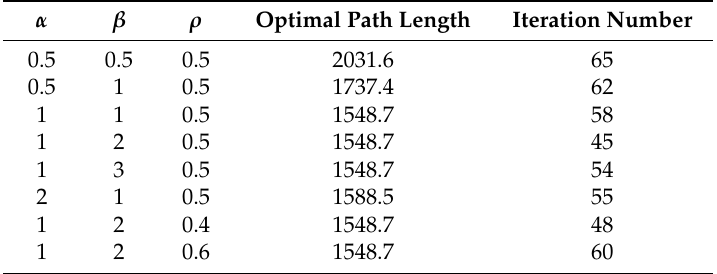
Table 3. Optimal path length under different ACO parameter combinations.